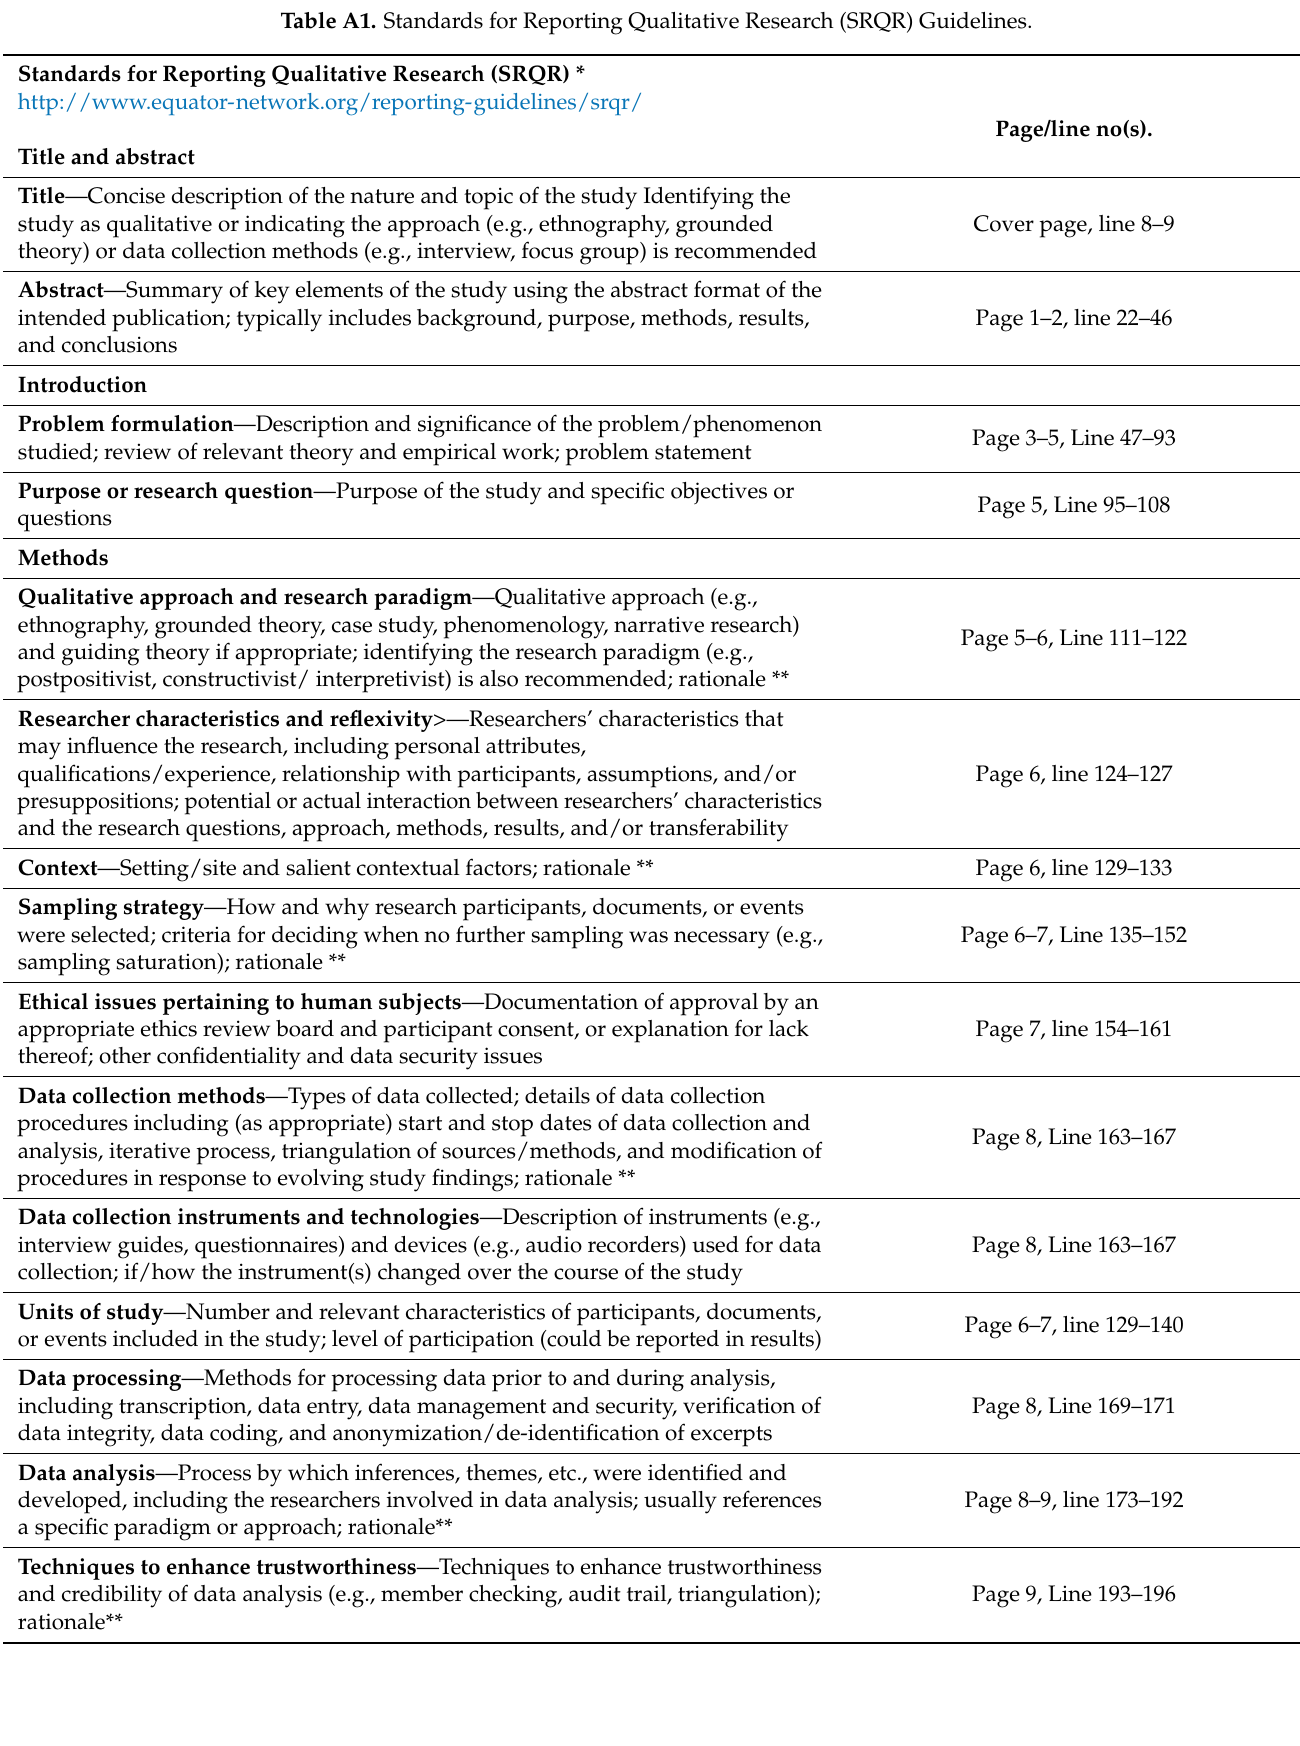
Table A1. Standards for Reporting Qualitative Research (SRQR)